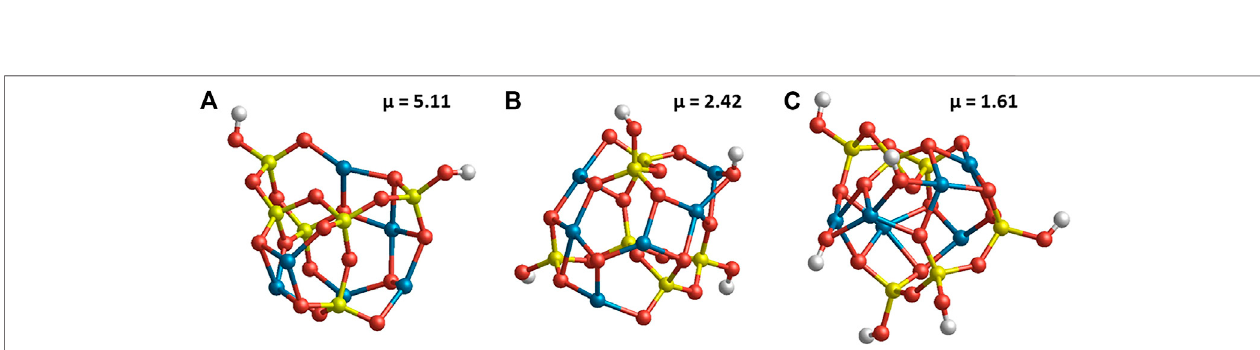
FIGURE 2 | Lowest energy hydroxylated (MgSiO 3 ) 6 nanosilicate structures found with (A) one, (B) two, and (C) three water molecules. Dipole moments for each nanocluster are given in Debyes. Atom color key: silicon – yellow, magnesium – blue, and oxygen — red.